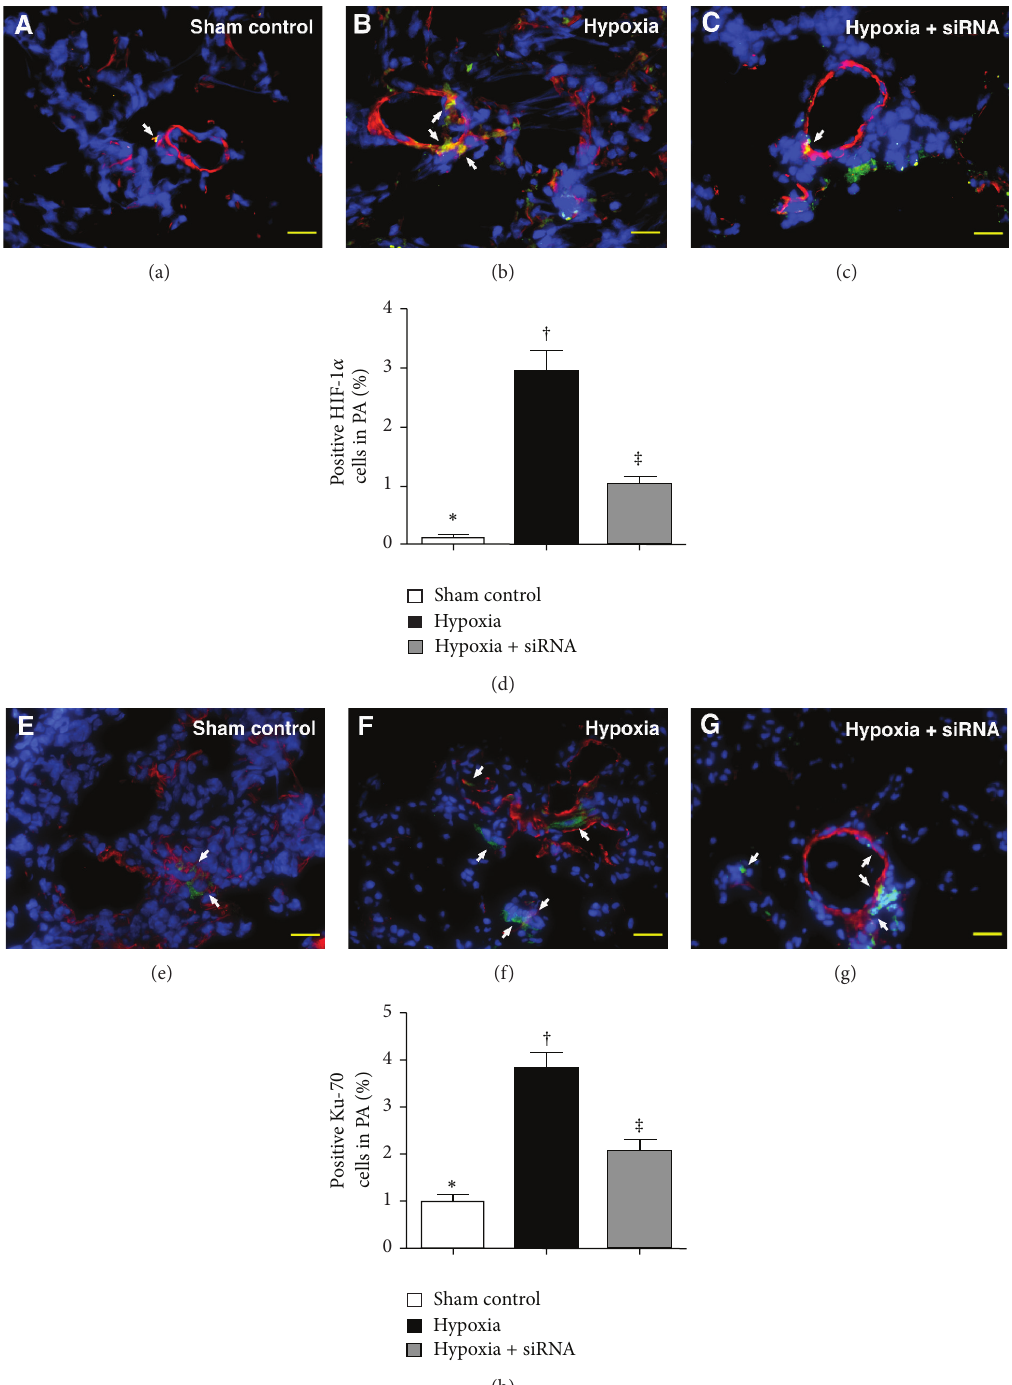
Figure 5: Immunofluorescent (IF) staining for HIF-1 𝛼 + cells and Ku-70+ cells in medial layer of large pulmonary arterioles (PA) by day 28 after pulmonary arterial hypertension (PAH) ( 𝑛 = 10 ). ((a) to (c)) Cellular expression of hypoxia-inducible factor- (HIF-) 1 𝛼 in PA (white arrow) after double staining (i.e., 𝛼 -SMA-HIF-1 𝛼 ) in the three groups of animals (400x). (d) ∗ versus other groups with different symbols ( ∗ , † , ‡ ), 𝑃 < 0.0001 . ((e) to (g)) Identification of Ku-70+ cells in PA (white arrow) using double staining (i.e., 𝛼 -SMA-Ku-70) in the three groups (400x). (h) ∗ versus other groups with different symbols ( ∗ , † , ‡ ), 𝑃 < 0.001 . The scale bars in right lower corners represent 20 𝜇 m. Blue fluorescence represents DAPI-stained nuclei. Statistical analysis in (d) and (h) using one-way ANOVA, followed by Bonferroni multiple comparison post hoc test. Symbols ( ∗ , † , ‡ ) indicate significance (at 0.05